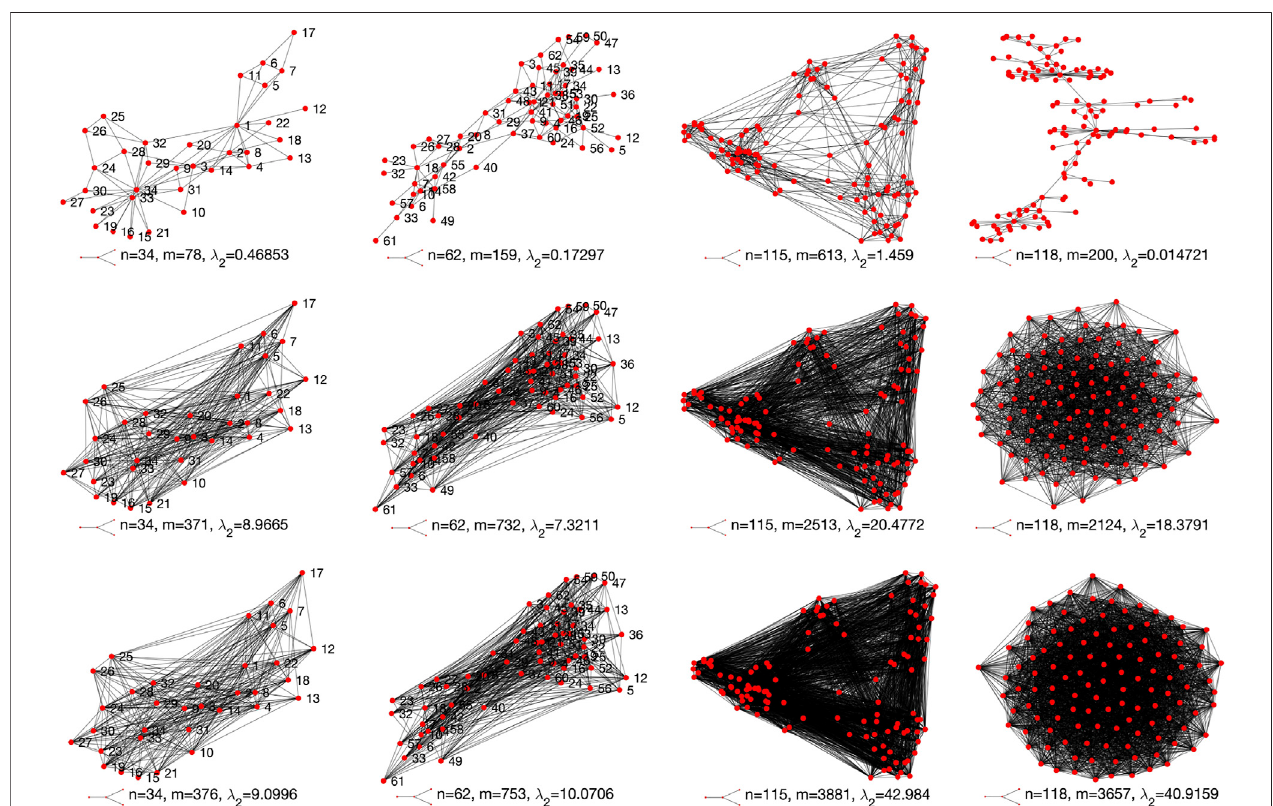
FIGURE 13 | Original ( fi rst row) and optimized structures (second and third rows) of the four tested real-world networks.